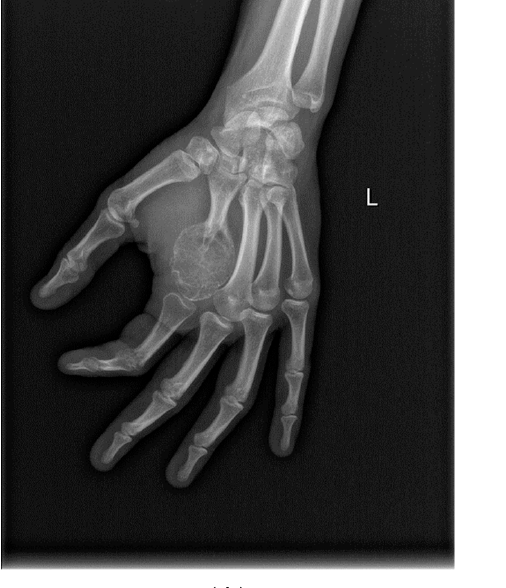
Figure 4. Significant calcification of the locally advanced GCTB of proximal tibia after 8 doses of denosumab (X ‐ rays). Prolonged denosumab treatment can aid resection of the initially inoperable cases. ( A ): Lesion before denosumab therapy, ( B ): after 8 doses of denosumab, ( C ): after the surgery with radical resection and implantation of oncological prosthesis.